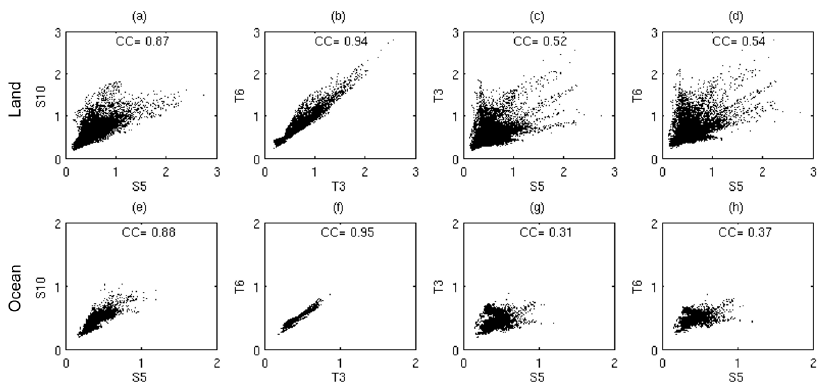
Figure 3. Scatter plots constructed from different spatial and temporal relative errors. Correlation coefficients (CC) are shown in each panel. Note the axes show relative errors and are dimensionless. The top and bottom rows represent land and ocean, respectively.